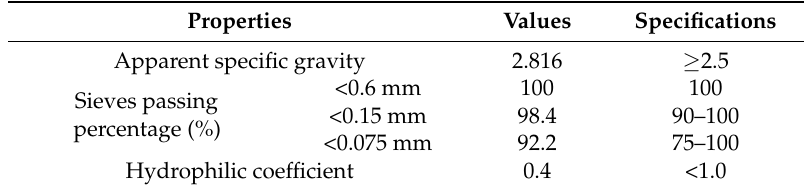
Table 4. Basic properties of limestone filler in this